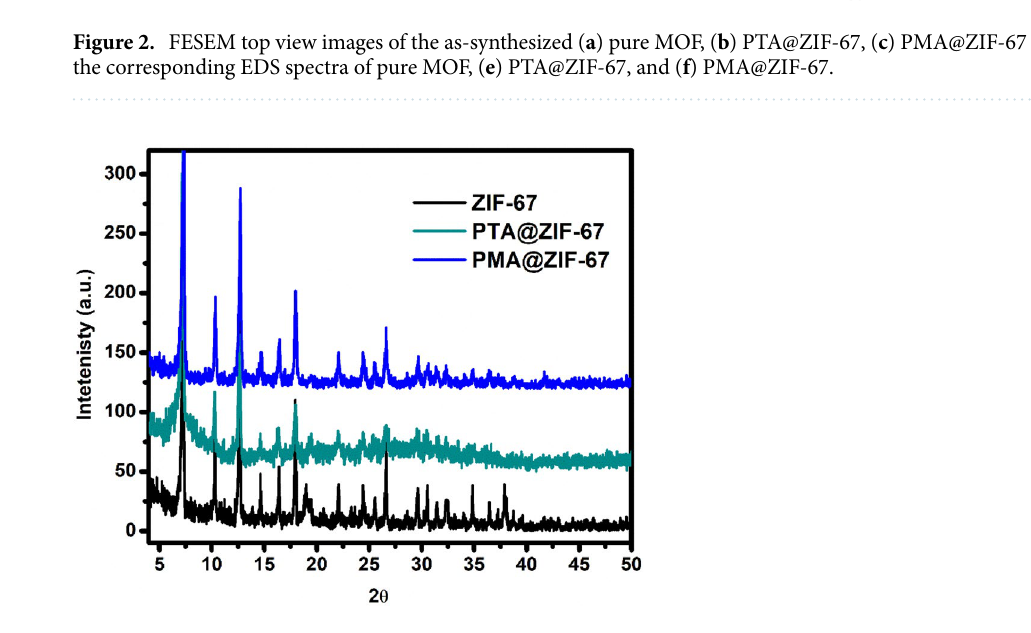
Figure 3. Shows the XRD patterns of before and after encapsulated ZIF-67